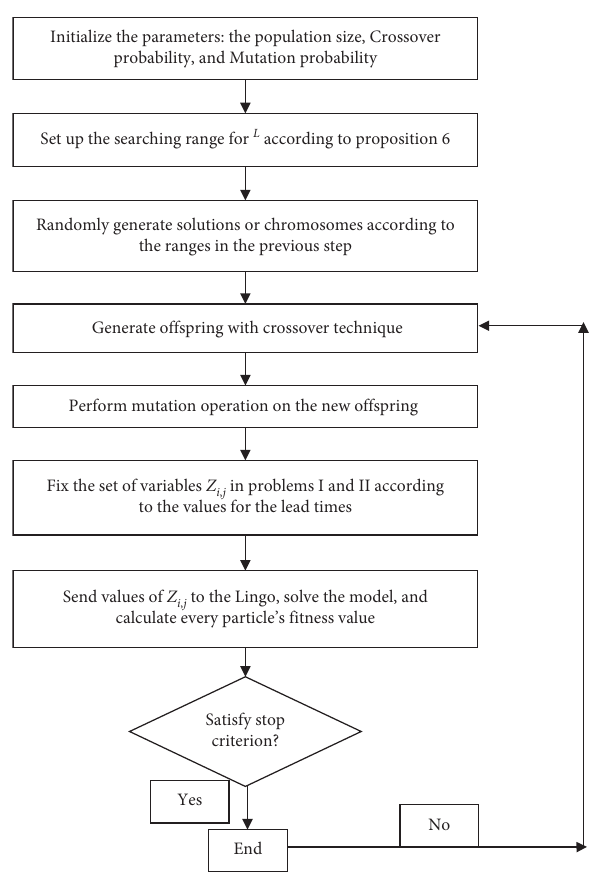
Figure 2: GA flowchart for pricing and due date